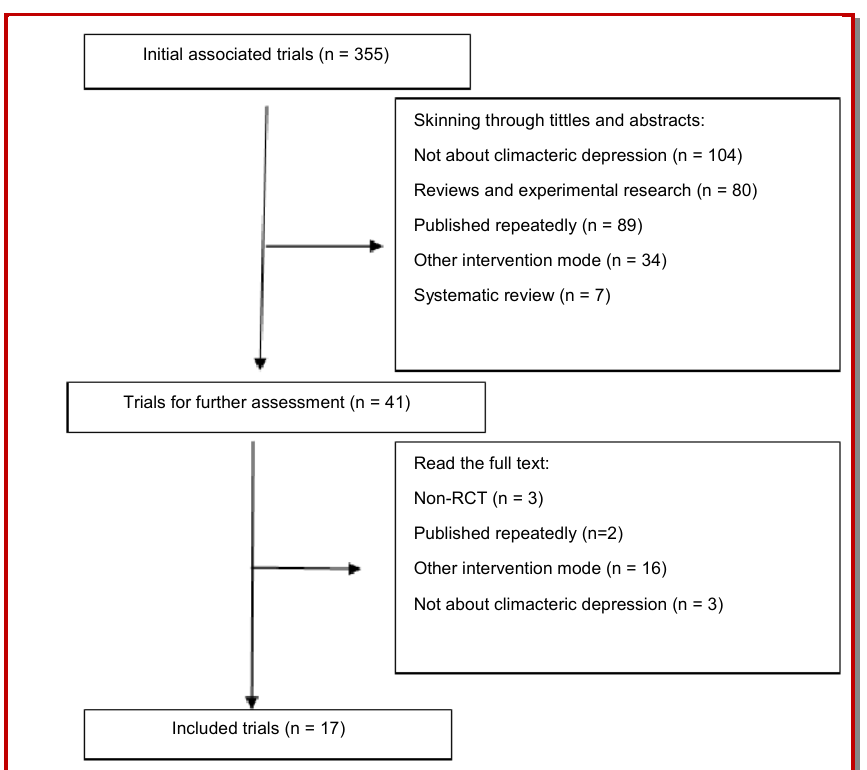
Figure 1: literature selection process for the systematic review